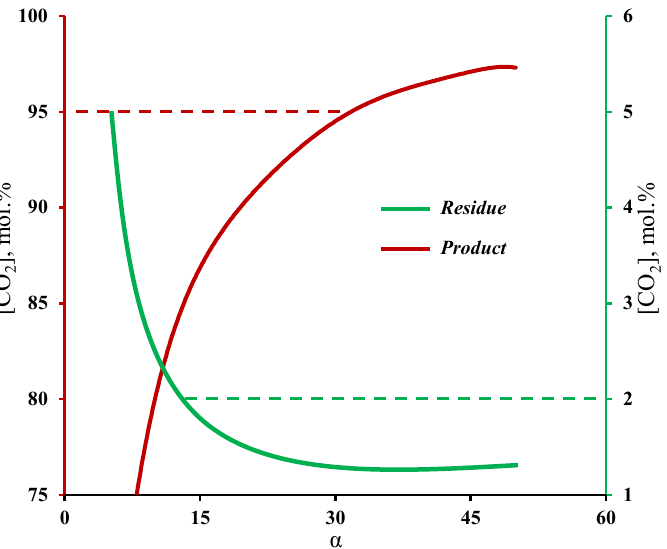
Figure 4. Dependence of carbon dioxide content in the streams withdrawn from the stripping and enrichment sections on the membrane selectivity at a fixed permeance value.